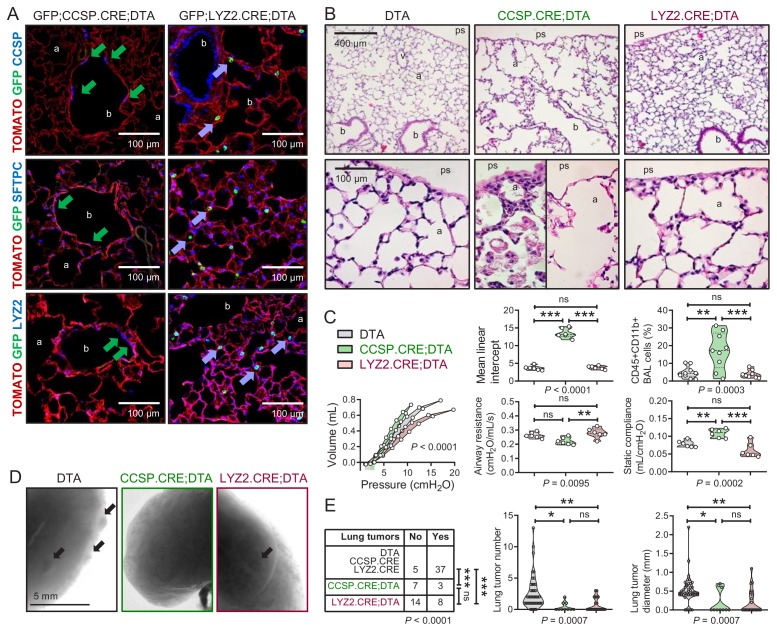
Airway cell-ablated mice display alveolar destruction and are protected from carcinogenesis.(A) Lineage marker-immunostained lung sections of 12-week-old GFP;CCSP.CRE;DTA and GFP;LYZ2.CRE;DTA mice (n = 6/group) show increased bronchial and alveolar size and flat CCSP+ SFTPC+ LYZ2+ cells in the airways of GFP;CCSP.CRE;DTA mice (green arrows), and CCSP-SFTPC-LYZ2+ alveolar macrophages in the airspaces of GFP;LYZ2.CRE;DTA mice (blue arrows). See also Figure 5—figure supplements 1 and 2. (B) Hematoxylin and eosin-stained lung sections (n = 6/group) from 12-week-old DTA (controls), CCSP.CRE;DTA (airway epithelial suicide model), and LYZ2.CRE;DTA (alveolar epithelial suicide model) mice. (C) Data summaries of mean linear intercept, bronchoalveolar lavage (BAL) myeloid cells, pressure-volume curves, airway resistance, and static compliance (n = 6–10/group) from 12-week-old DTA, CCSP.CRE;DTA, and LYZ2.CRE;DTA mice shown as violin plots. P, probabilities, one-way ANOVA. ns, **, and ***: p>0.05, p<0.01, and p<0.001, respectively, for the indicated comparisons, Bonferroni post-tests. (D) Lung photographs of control, CCSP.CRE;DTA, and LYZ2.CRE;DTA mice at six months into treatment with urethane started at six weeks of age. (E) Incidence table and data summaries of lung tumors from (D) (violin plots; n is given in table). P, probabilities, χ2-test (table) and one-way ANOVA (graphs). ns, *, **, and ***: p>0.05, p<0.05, p<0.01, and p<0.001, respectively, for the indicated comparisons, Fischer’s exact tests (table) or Bonferroni post-tests (graphs). a, alveoli; b, bronchi; ps, pleural space; v, vessel. CCSP, Clara cell secretory protein; SFTPC, surfactant protein C; LYZ2, lysozyme 2.10.7554/eLife.45571.056Figure 5—source data 1.Quantifications of data shown in Figure 5C.10.7554/eLife.45571.057Figure 5—source data 2.Quantifications of data shown in Figure 5D and E.